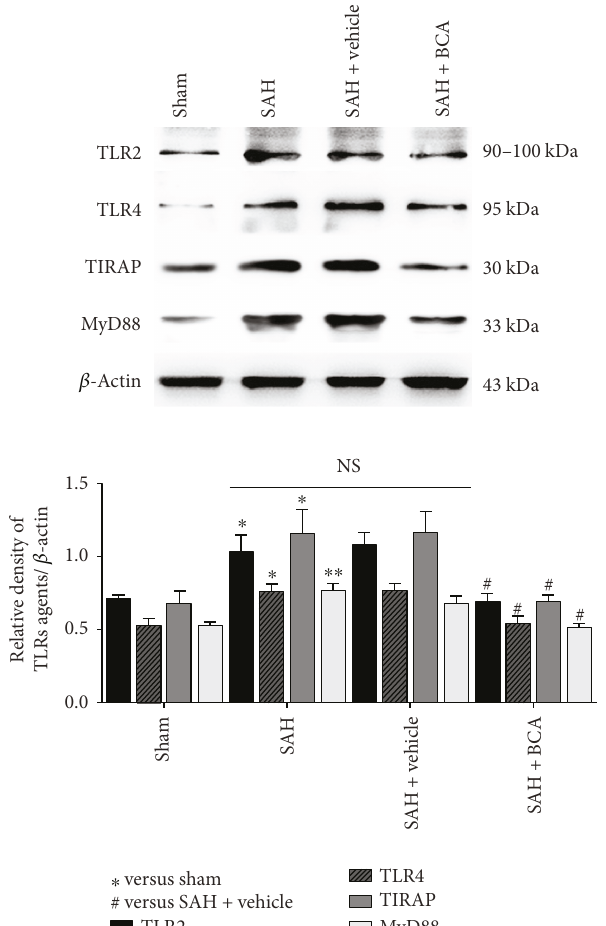
Figure 5: The e ff ects of BCA on TLR2/TLR4/TIRAP/Myd88 signal protein expression at 24 hours post SAH ( n = 6 , each group; ∗ P < 0 05 and ∗∗ P < 0 01 versus sham; # P < 0 05 versus SAH+vehicle; NS P > 0 05